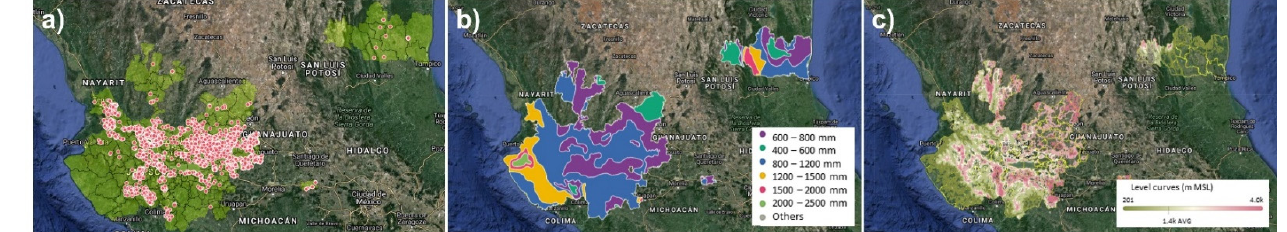
Figure 6. Maps corresponding to the region granted by the DOT: ( a ) geographical location of properties where Agave tequilana Weber blue variety jima was grown in the year 2020; ( b ) accumulated annual precipitation contour map; ( c ) altitude contour map with respect to sea level.